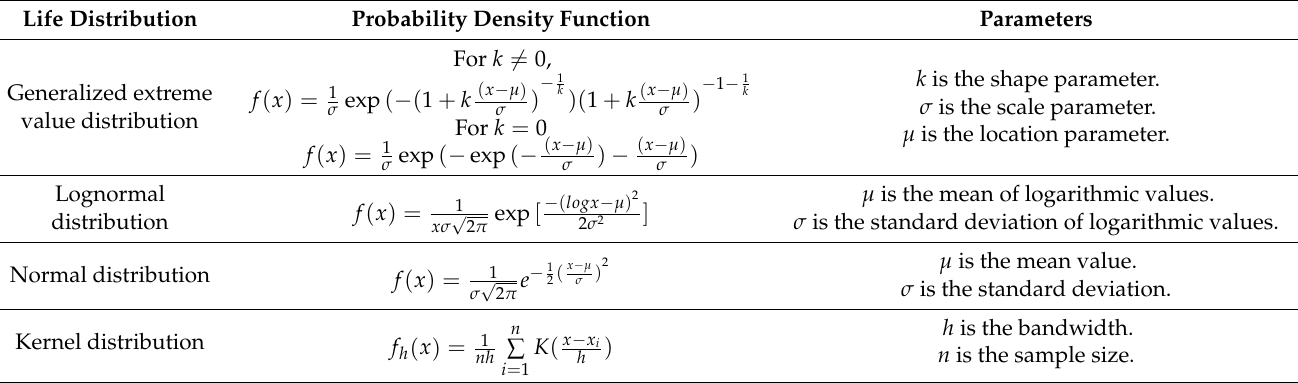
Table 1. The probability density function and their parameters.